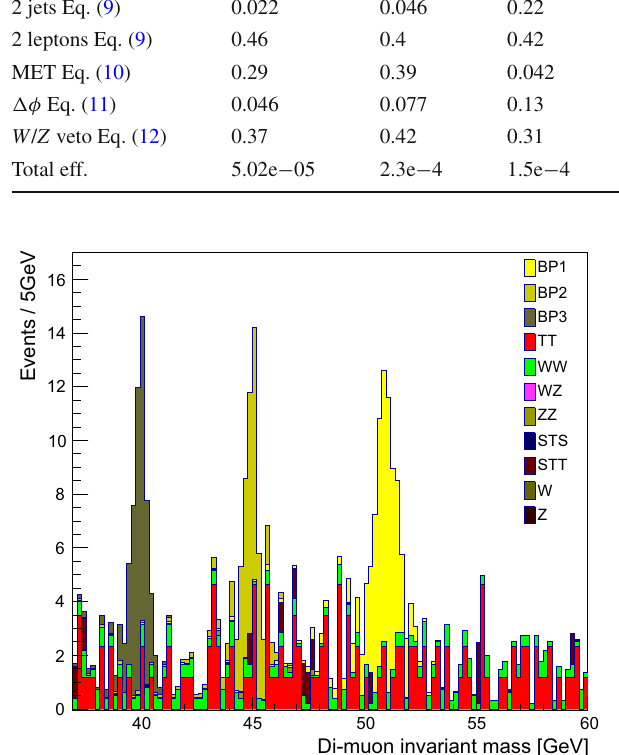
Fig. 7 The distribution of di-lepton invariant mass in signal and back- ground events